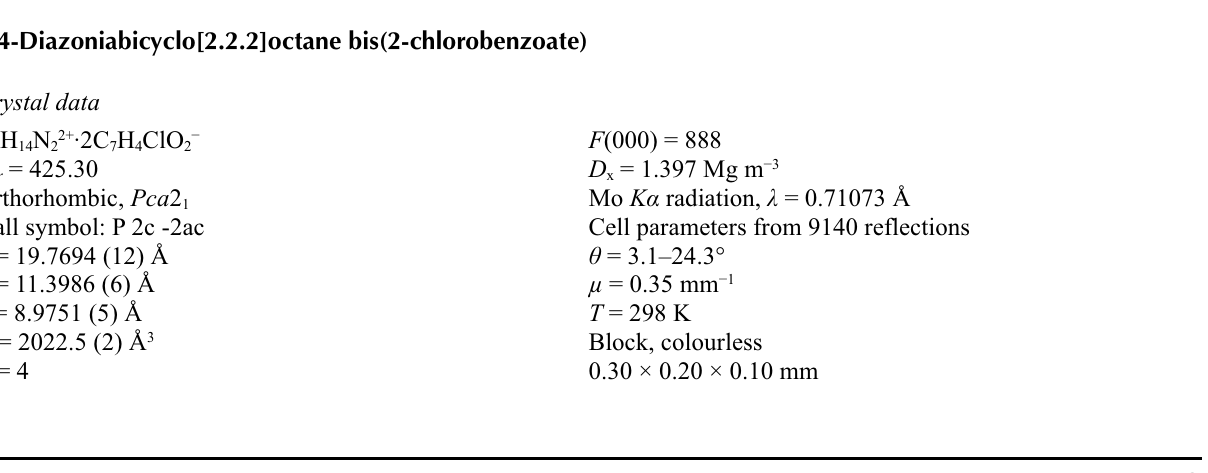
View along the b axis. The light blue lines denote N + —H···O - hydrogen bonds. 1,4-Diazoniabicyclo[2.2.2]octane